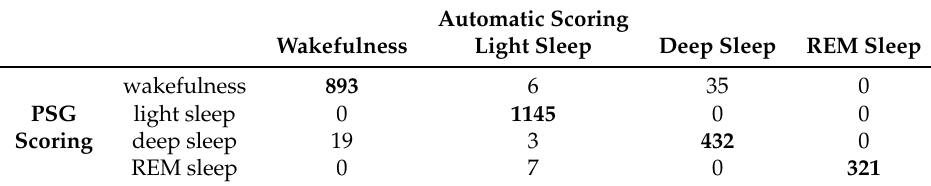
Table 4. Confusion matrix for patients with insomnia.